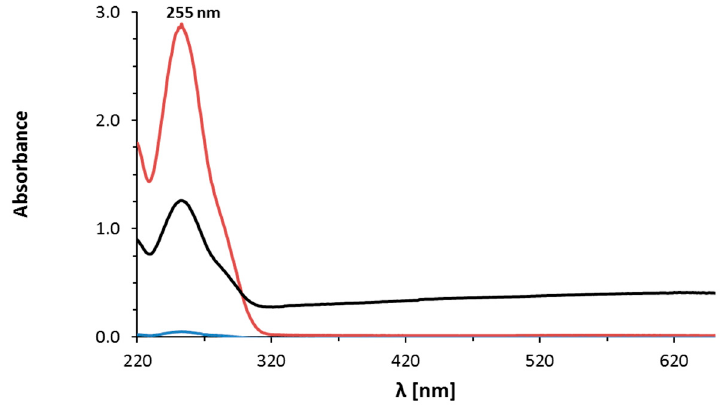
Figure 2. Control of abiraterone in the supernatant by the UV-Vis technique: after one centrifugation (red line); after two centrifugations (black line); after three centrifugations (blue line): below the limit of detection (LOD).